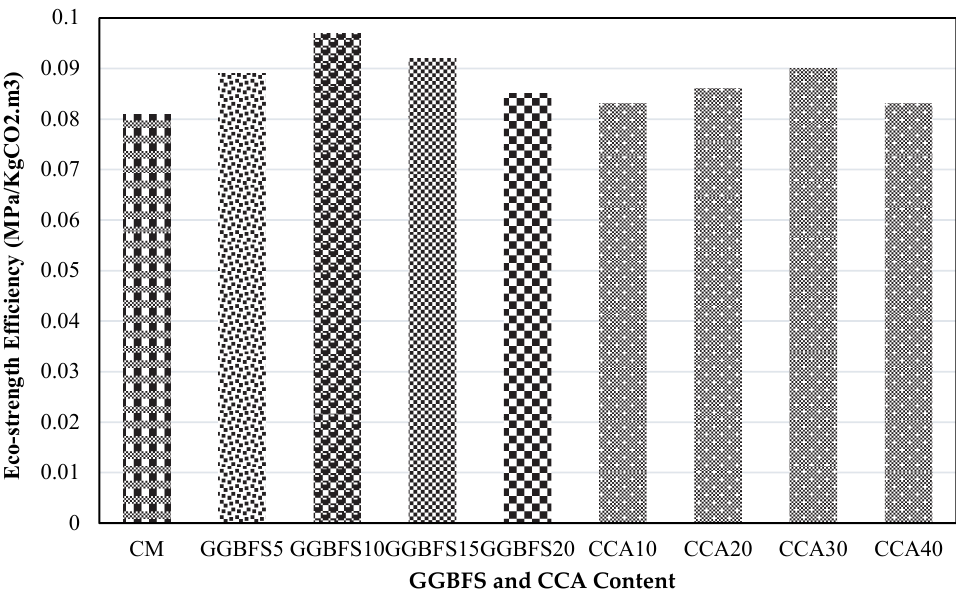
Figure 20. Eco-strength efficiency of concrete containing GGBFS and CCA.